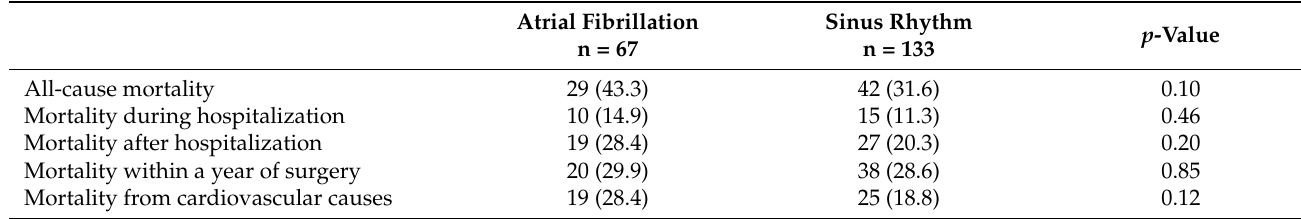
Table 2. Comparison of mortality of patients with atrial fibrillation and sinus rhythm.